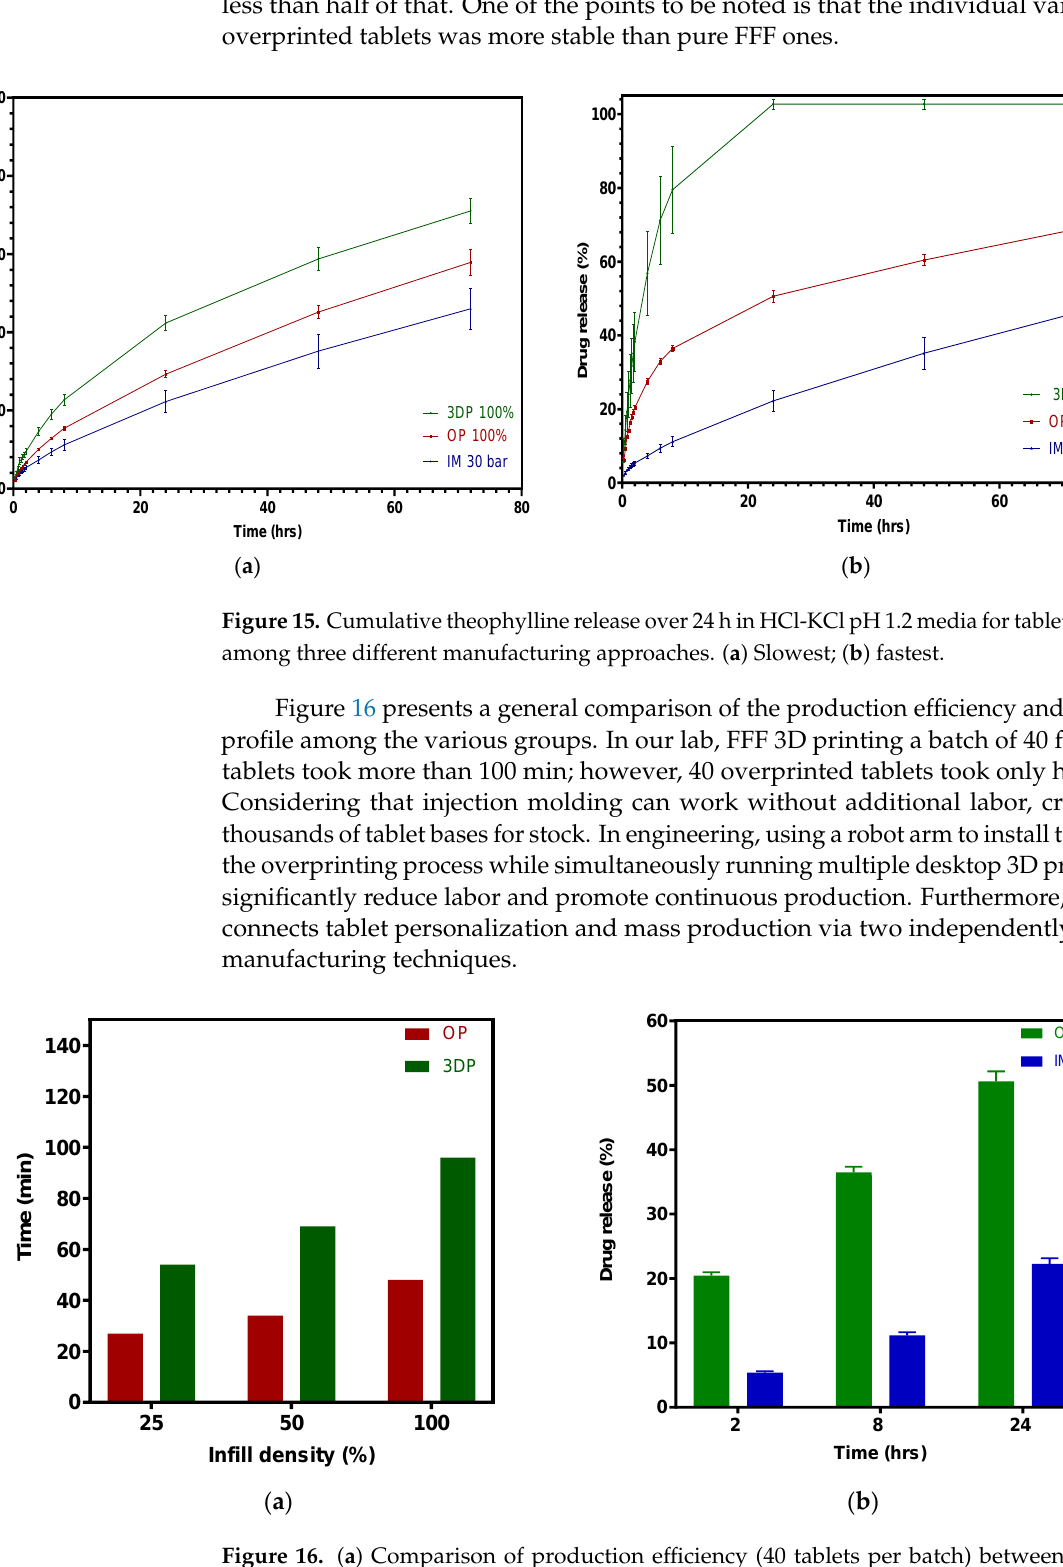
( b ) Figure 14. Cumulative theophylline release over 72 h in HCl-KCl pH 1.2 media for tablets: ( a ) over- printed, 6 solid layers; ( b ) overprinted, no solid layers. A comparison of the three different manufacturing methods for drug release is